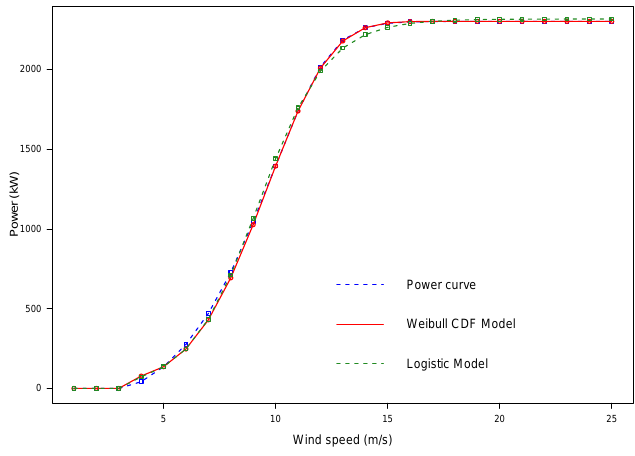
Figure 5. Weibull CDF and 4P-OP models for the Nordex N90 2-MW power curve.